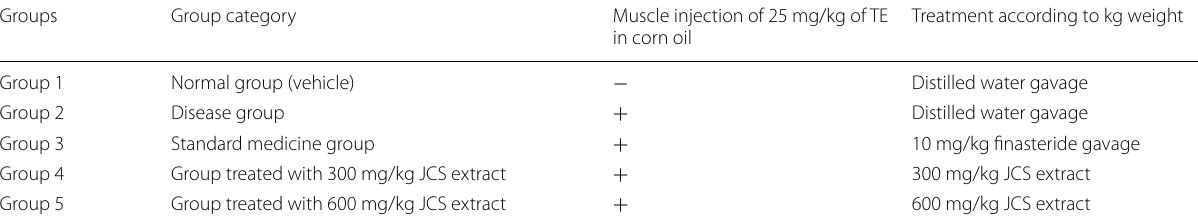
Table 1 Design of experimental